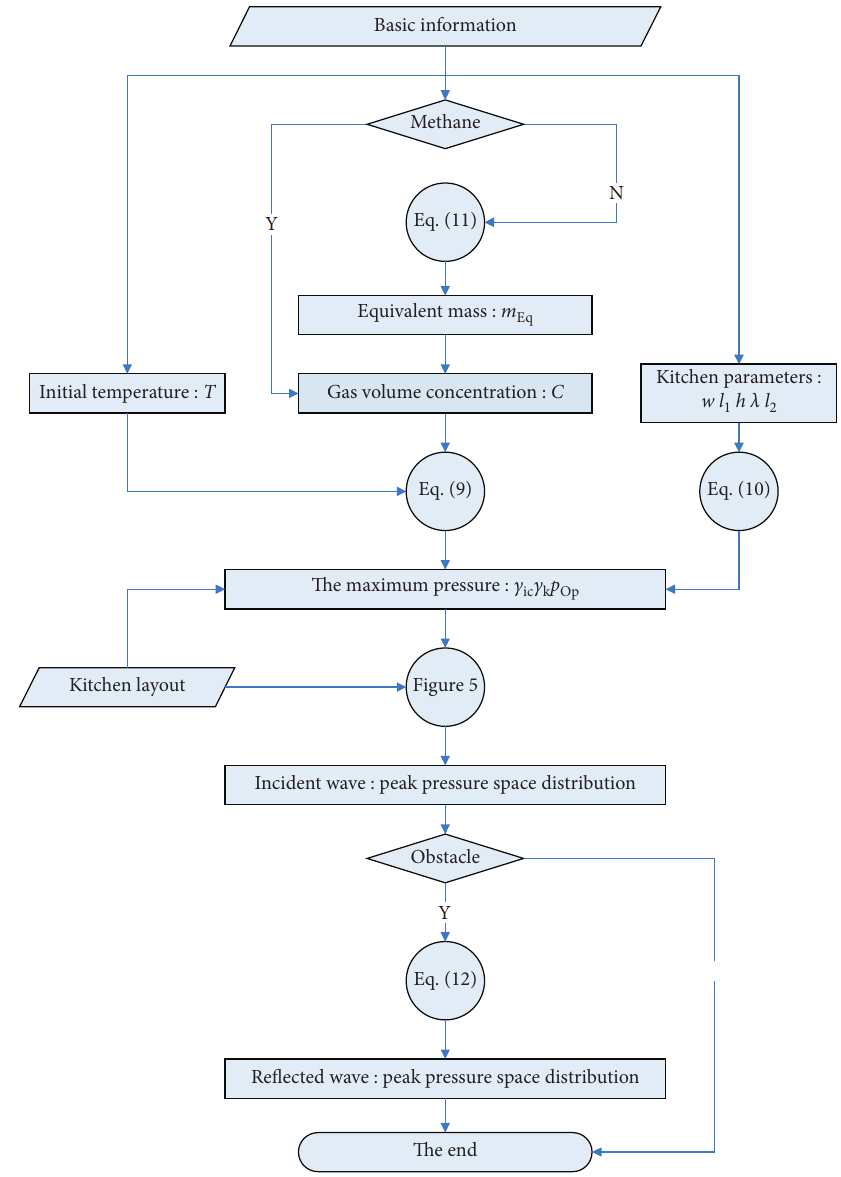
Figure 10: Flow chart of the proposed